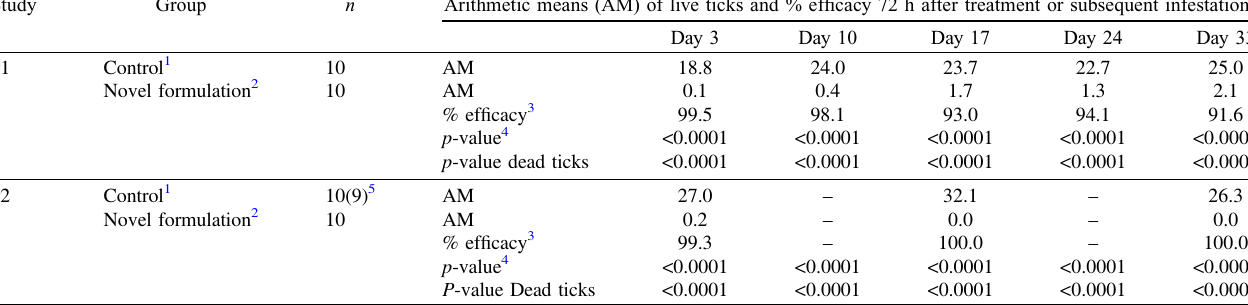
Table 2. Ef fi cacy of NexGard (cid:1) Combo against Amblyomma americanum. Study Group